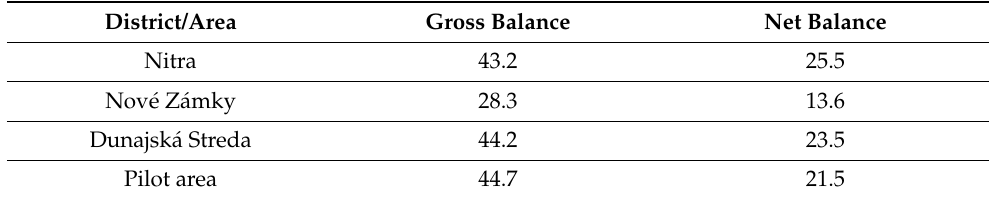
Table 4. Average values of nitrogen surplus on district/area level in period 2015–2018 (kg N ha − 1 of UAL).